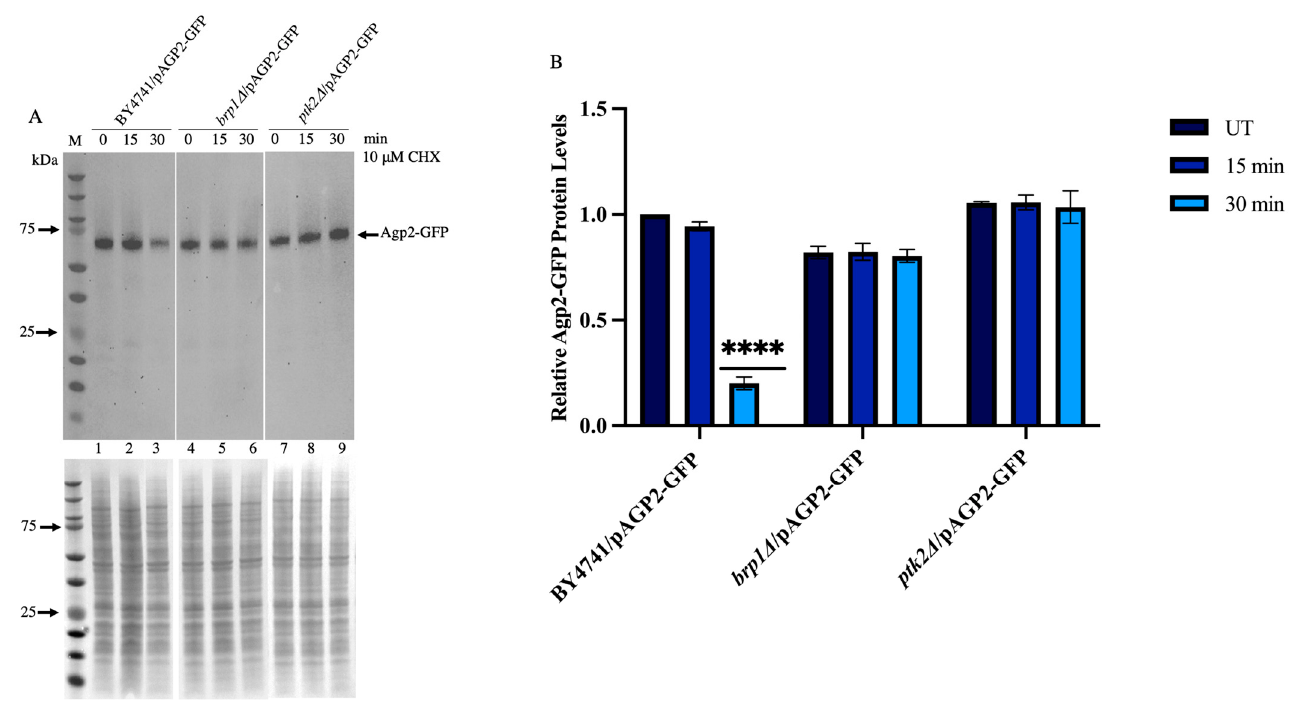
Figure 6. Comparison of Agp2-GFP levels between the WT (BY4741) and the brp1 ∆ and ptk2 ∆ mutants upon treatment with the indicated doses of CHX. ( A ) The crude plasma membrane fraction was prepared as in Figure 5A following treatment with 10 µM CHX for 0, 15 and 30 min and analyzed by immunoblot. Ponceau staining of the immunoblot to monitor for protein loading. ( B ) Quantification of the relative level of Agp2-GFP under the various treatment conditions. M, prestained protein markers in kDa. Error bars indicate S.E. The data are representative of three biological replicates and analyzed by 2-way Anova Test. **** Is equivalent to p -value < 0.0001